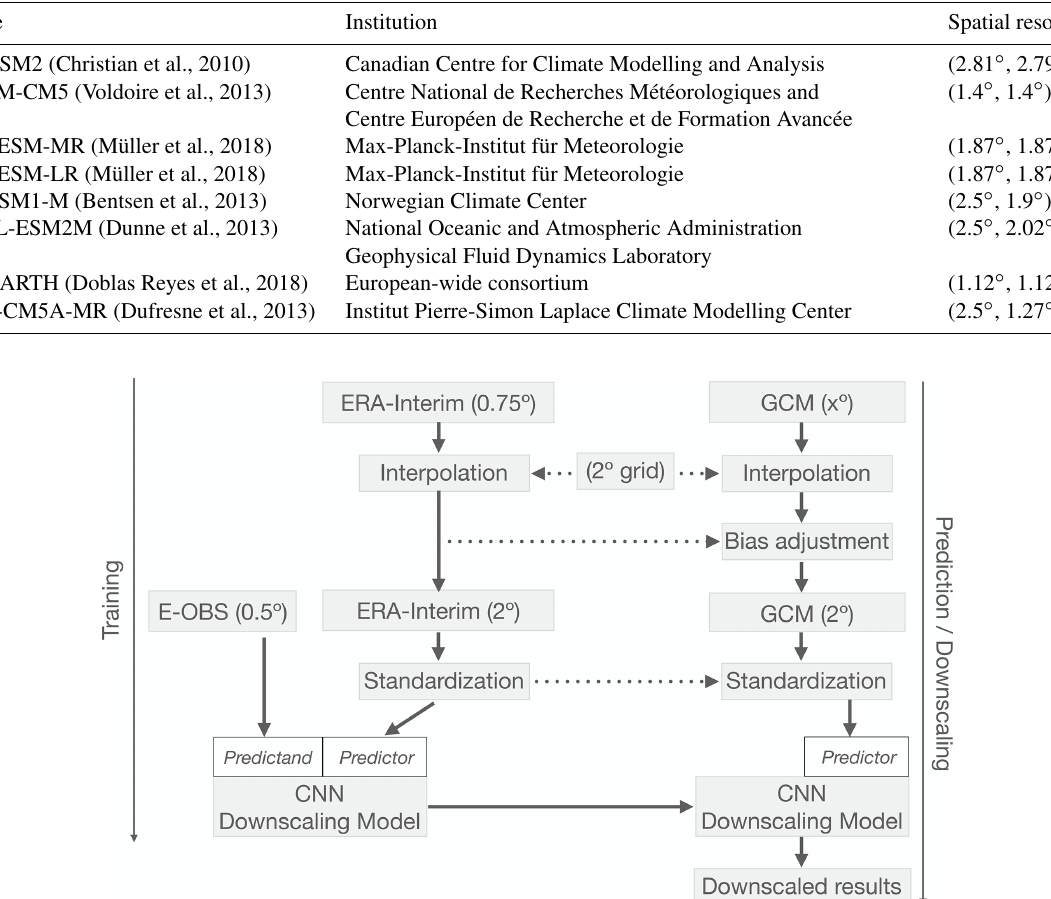
Figure 1. Workflow of pre-processing steps applied to reanalysis and GCM data in this